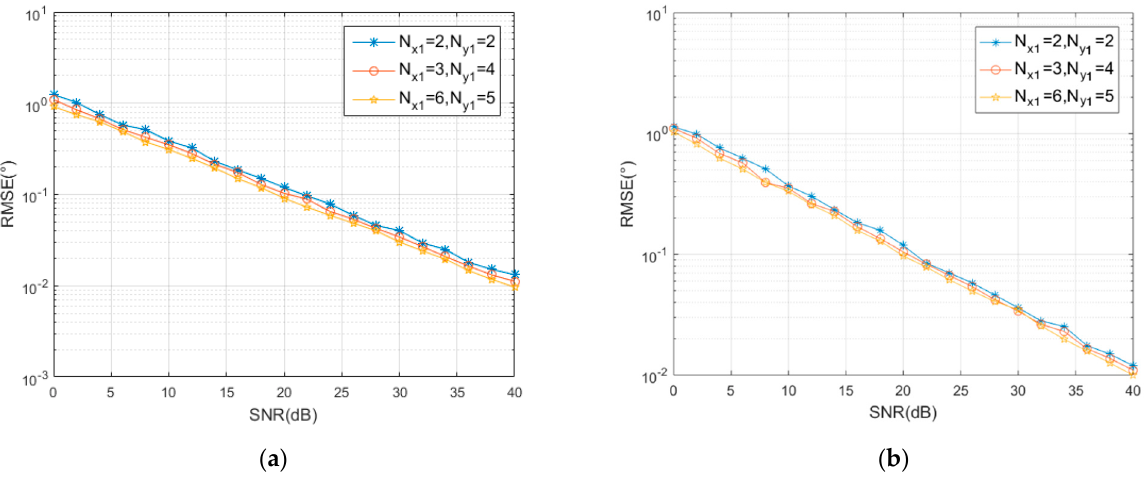
Figure 8. DOA estimation RMSE with different auxiliary array elements for different source numbers. ( a ) 1 source located on ( 25 ◦ ,30 ◦ ) ; ( b ) 3 sources located on ( − 20 ◦ ,30 ◦ ) , ( 0 ◦ ,15 ◦ ) , and ( 10 ◦ , − 15 ◦ )